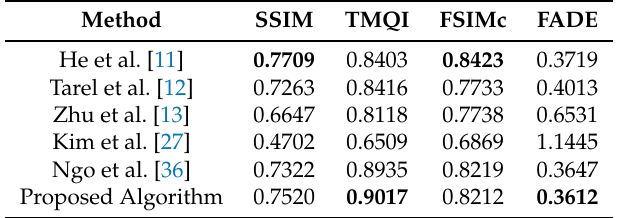
Table 6. Average SSIM, TMQI, FSIMc, and FADE scores on O-HAZE dataset.